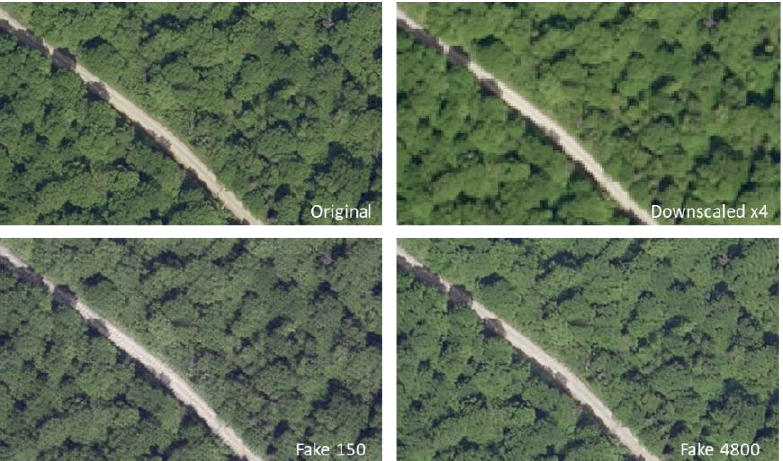
Figure 7. Example of results that were obtained for 150 and 4800 epochs on an image belonging to the "forest" theme.